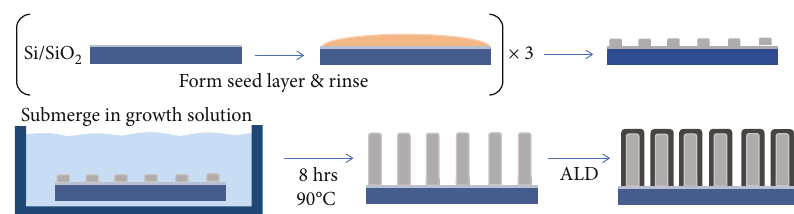
Figure 2: A hybrid ALD/hydrothermal process is used to fabricate the TiO @ZnO nanowires. ZnO nanowires are grown hydrothermally. 2 First, a quantum dot seed layer is formed on the surface of an oxidized silicon wafer. The seed layer forms the basis upon which the nanowires grow. Next, the wafer is submerged into Zn-rich growth solution for 8 hours at 250 ° F; nanowire height can be tuned via growth time. Finally, the ZnO nanowires are coated with TiO using ALD. 2